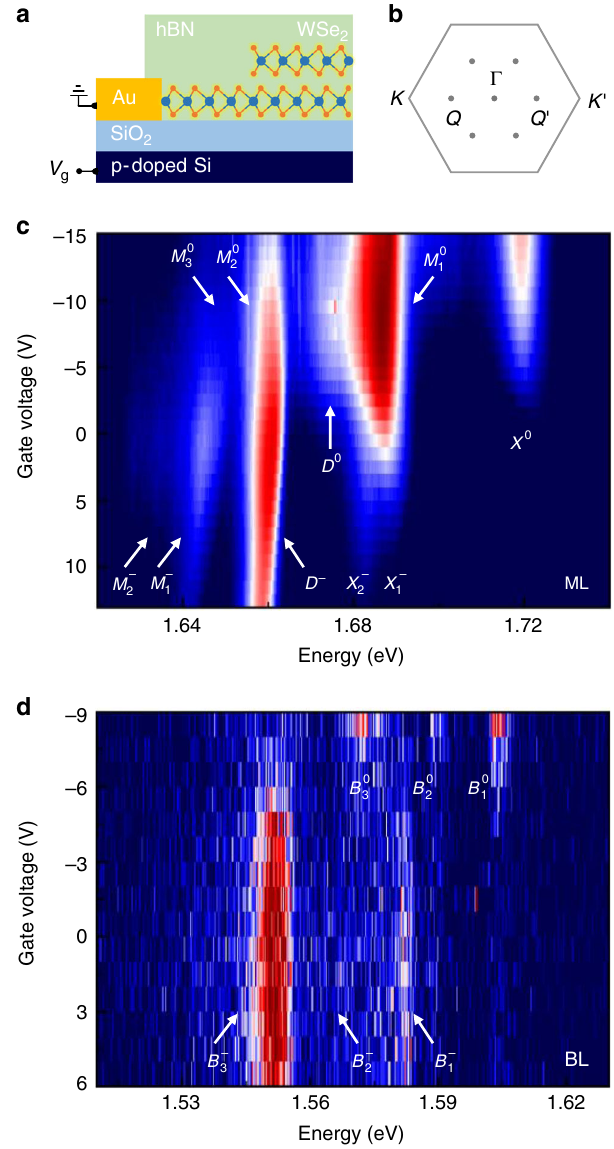
Fig. 1 Sample layout and charge-doping control of monolayer and bilayer WSe 2 . a Schematics of the fi eld-effect device with monolayer and bilayer WSe 2 encapsulated in hBN. b First Brillouin zone with high symmetry points. c , d Logarithmic false-color plots of the photoluminescence as a function of the gate voltage, recorded at representative positions of monolayer and bilayer WSe 2 , respectively. The monolayer features characteristic photoluminescence of neutral bright ( X 0 ) and dark ( D 0 ) excitons, as well as the negatively charged bright trion doublet ( X (cid:1) and dark trion ( D − ). All other peaks of monolayer ( M ) and bilayer ( B ) photoluminescence are labeled according to their charge state in the superscript and an increasing subscript